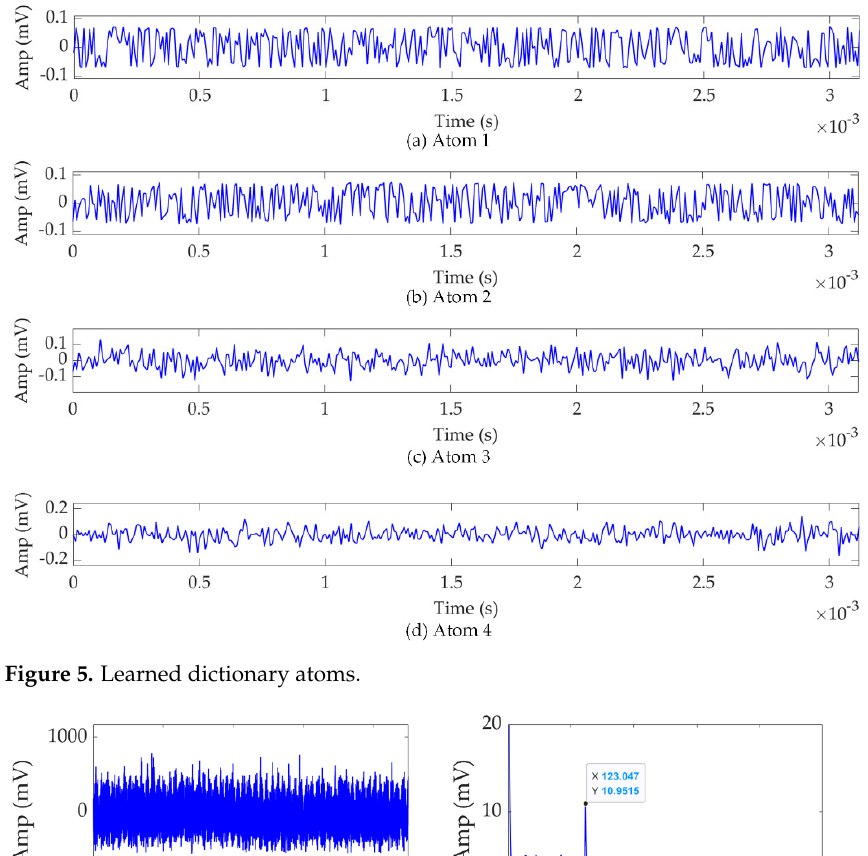
Figure 6. ( a ) The denoised signal waveform by SR and ( b ) its frequency